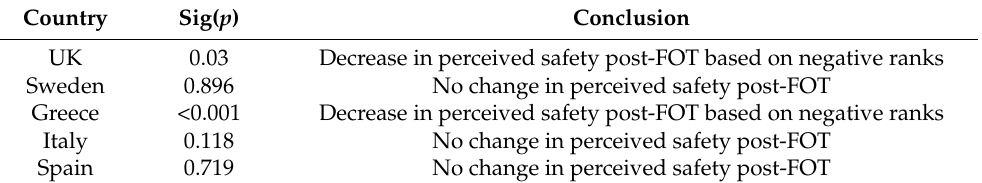
Figure 1. Navigation: perception of safety pre- and post-field operational test (FOT). Table 2. Navigation: Wilcoxon test for differences in pre-/post-FOT